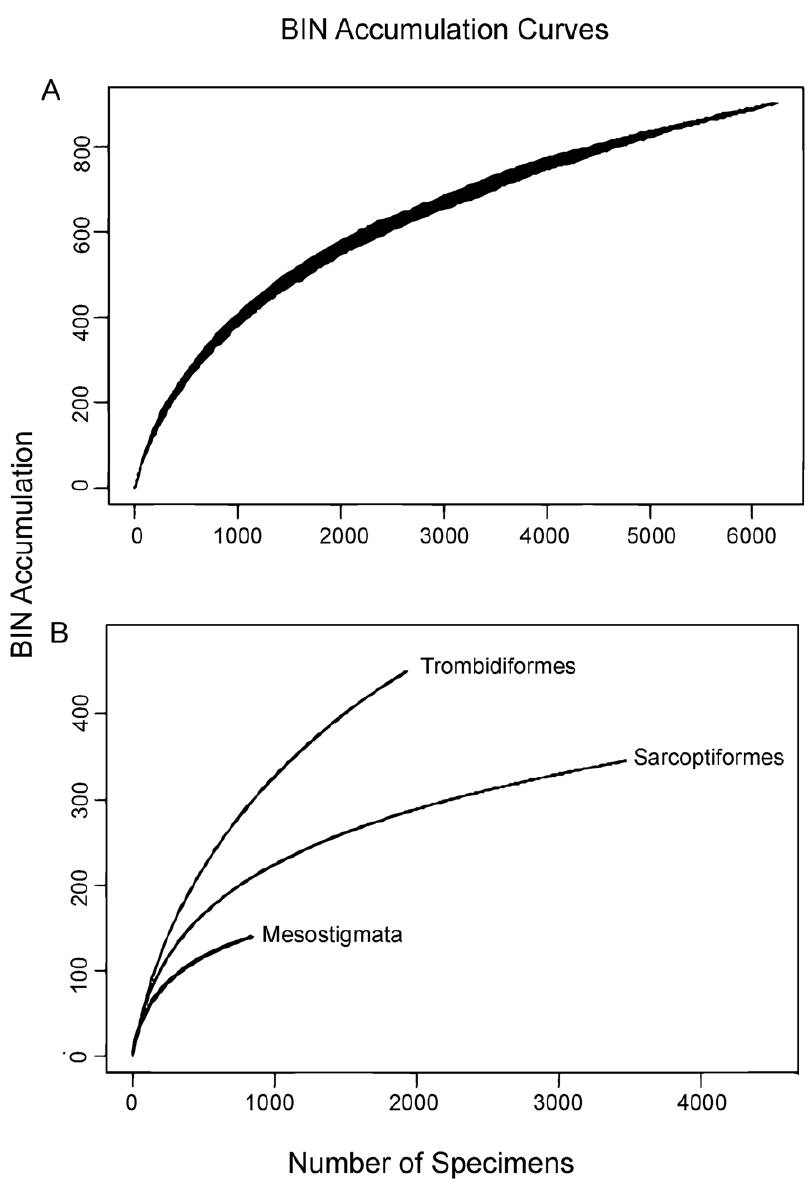
Figure 2. Bin accumulation curves. Curves represent a) the overall dataset, with 899 BINs from 6279 samples, and b) curves for each order - Trombidiformes (437 BINs, n=1933), Mesostigmata (135 BINs, n=849), and Sarcoptiformes (327 BINs, n=3497). curves for all trombidiform families are unsaturated (Figure 7), implying general undersampling of this order. By contrast, all families of Sarcoptiformes except the Suctobelbidae and Bra-